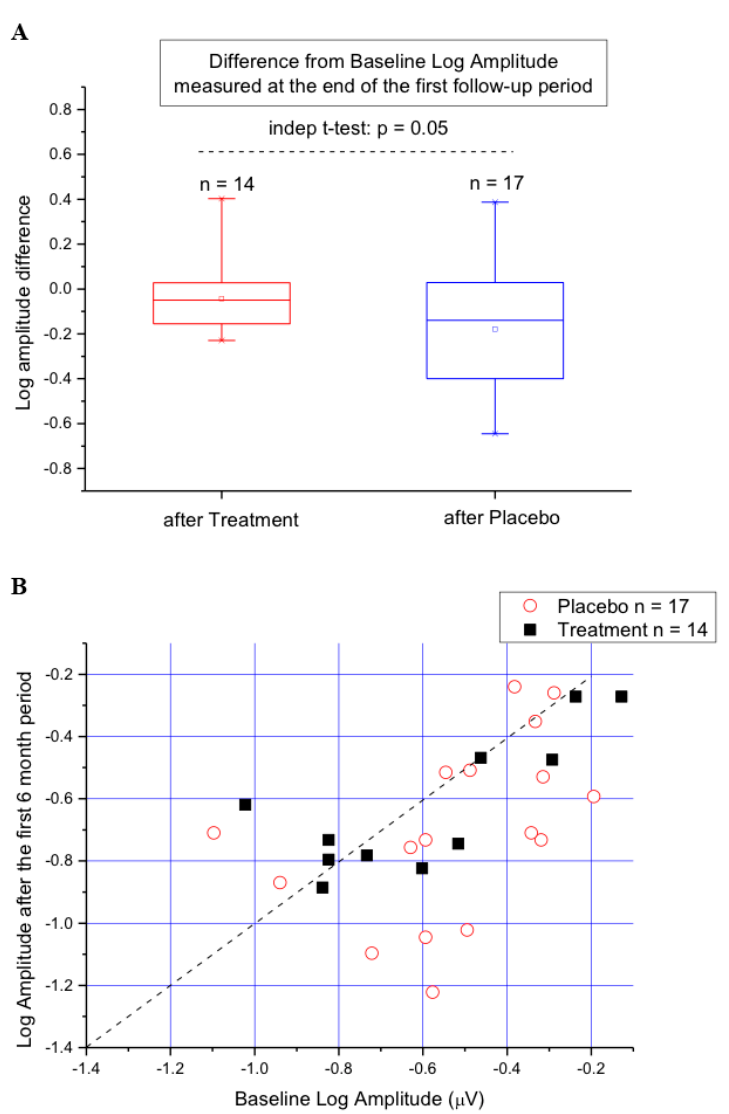
Figure 2. ( A ) Box plot showing the di ff erence from baseline fERG Log amplitude recorded at the end of the first six-month study period in patients assuming S (Treatment) and those assuming P (Placebo). ( B ) The same changes recorded in A shown as a scatter of data points. The diagonal line in the plot indicates equivalence. It can be noted that in seven out of 17 patients assuming P, fERG amplitude losses were substantially larger compared to those recorded in the 14 patients assuming S.